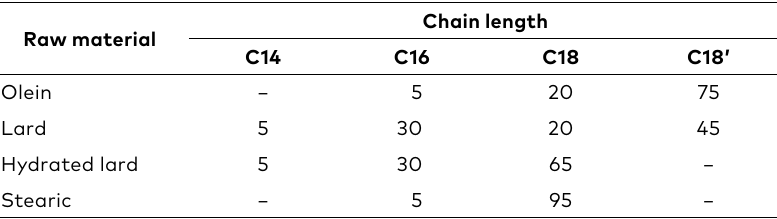
Table 1. Composition of alkyl groups in fatty